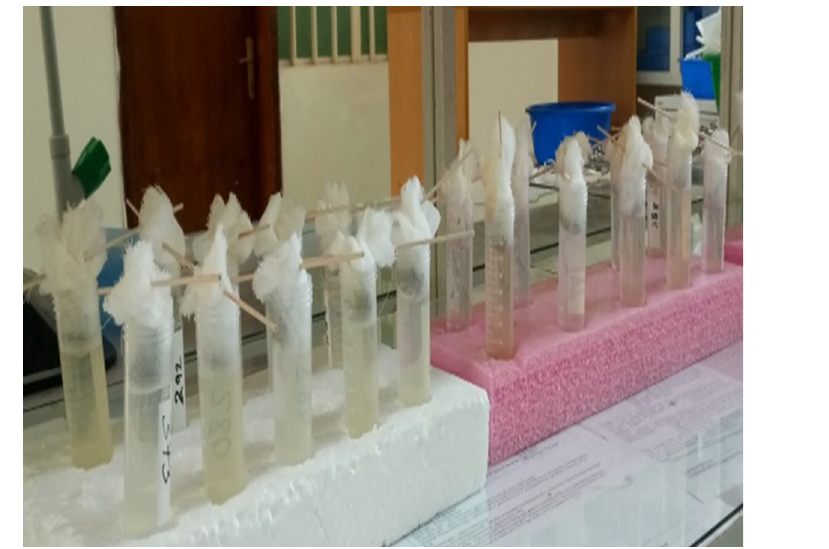
Fig 3. Suspension of stool samples in 50 mL tubes with lukewarm